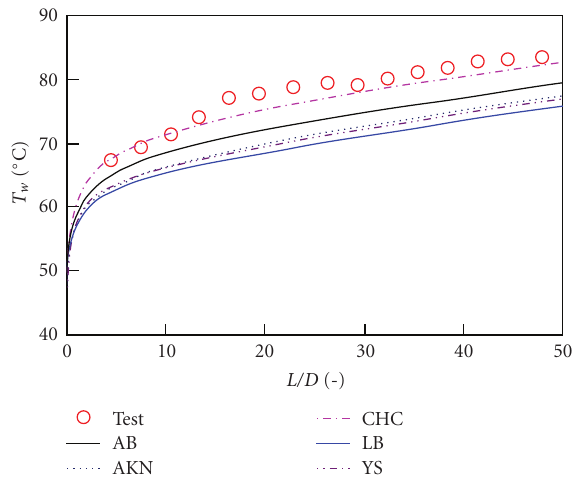
Figure 5: Comparison of numerical results with experimental data. AB: model of Abid; AKN: model of Abe/Kondoh/Nagano; CHC: model of Chang/Hsieh/Chen; LB: model of Lam/Bremhost; YS: model of Yang/Shih.